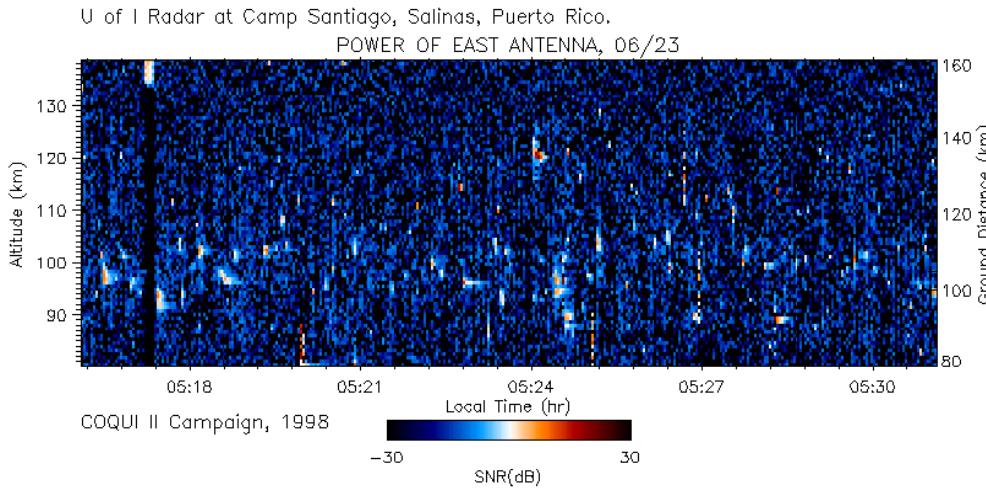
Figure 1 The extreme change of meteor echo occurrence and durations observed before and after dawn (reproduced from Chapin and Kudeki, [1994a]). Over 125 meteor echoes are observed from the start of the image until an abrupt break in meteor reflection occurrence near sunrise at 6:20 LT(after which only ~20 trails are observed).